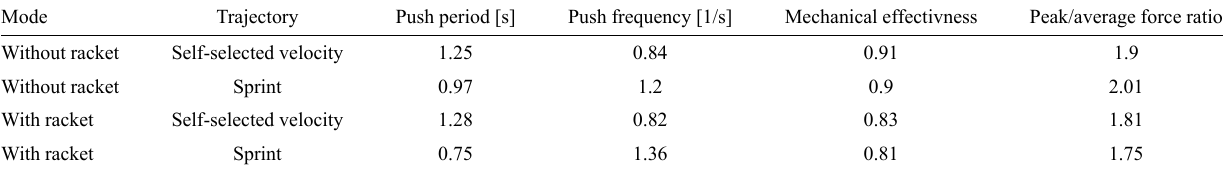
Table 2 - Average propulsive forces (measured by the SmartWheel system ), in two trajectories of movement, with and without the racket in the right hand. Mode Without racket Without racket With racket With racket